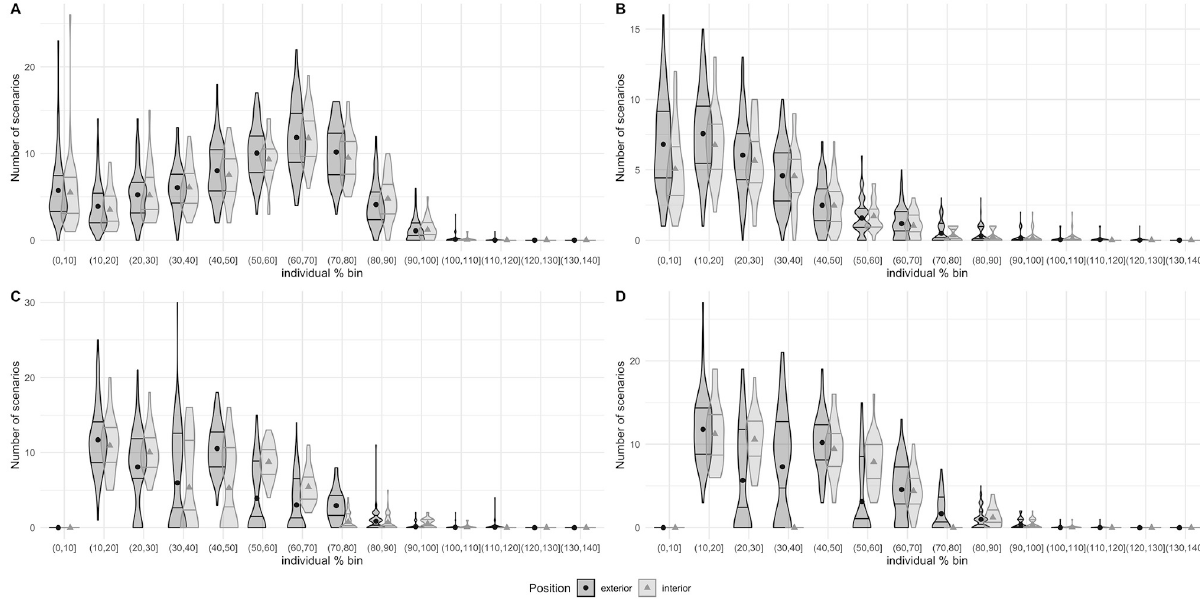
Fig 3. There is a graphical descriptive number of 30 s scenarios (mean, quartile 1 and quartile 3) in a match for each intensity bucket for each variable. Exterior players are shown in dark grey and interior players in light grey. A: distance travelled; B: high-speed skating; C: high-intensity accelerations; D: high-intensity